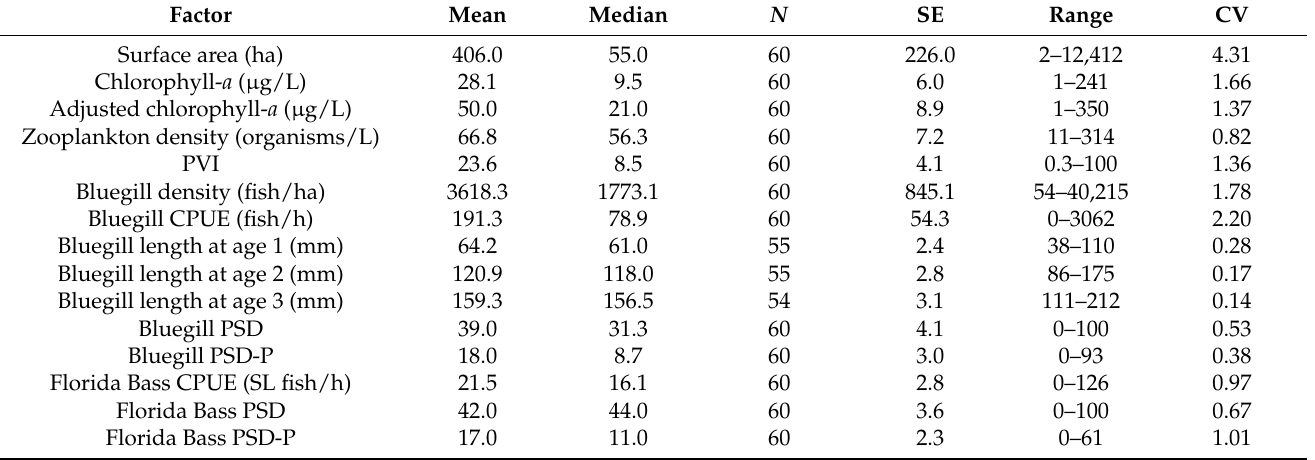
Table 1. Characteristics of Florida lakes in this study summarized by mean, median, number of lakes ( N ), standard error of the mean (SE), range, and coefficient of variation (CV). Adjusted chlorophyll- a concentration is the projected chlorophyll- a concentration value if nitrogen and phosphorus in aquatic macrophytes were added to the water column. Bluegill density was measured using rotenone applied to 0.08 ha block nets. Abbreviations include percent of total lake volume inhabited by macrophytes (PVI), electrofishing catch per unit effort (CPUE), proportional size distribution (PSD), PSD of preferred-length fish (PSD-P), and stock length (SL). Sample sizes are reduced for Bluegill lengths at age because, in some lakes, fish were not collected on the first day of rotenone sampling, when otoliths were removed to evaluate